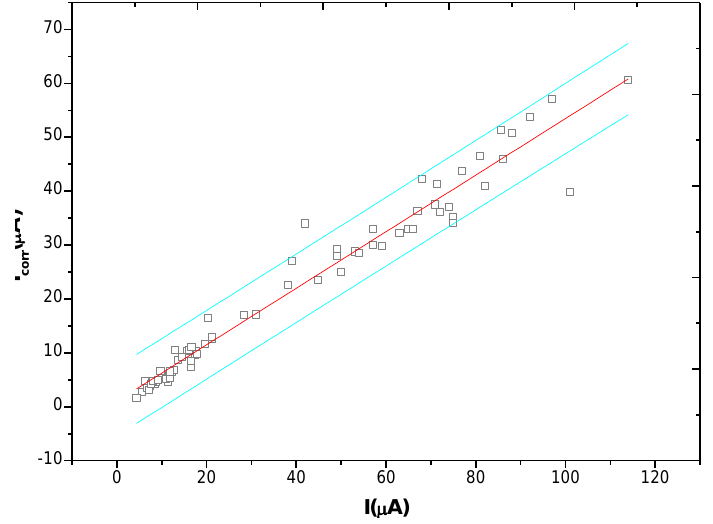
Figure 17. Relationship between corrosion current and anodic polarization